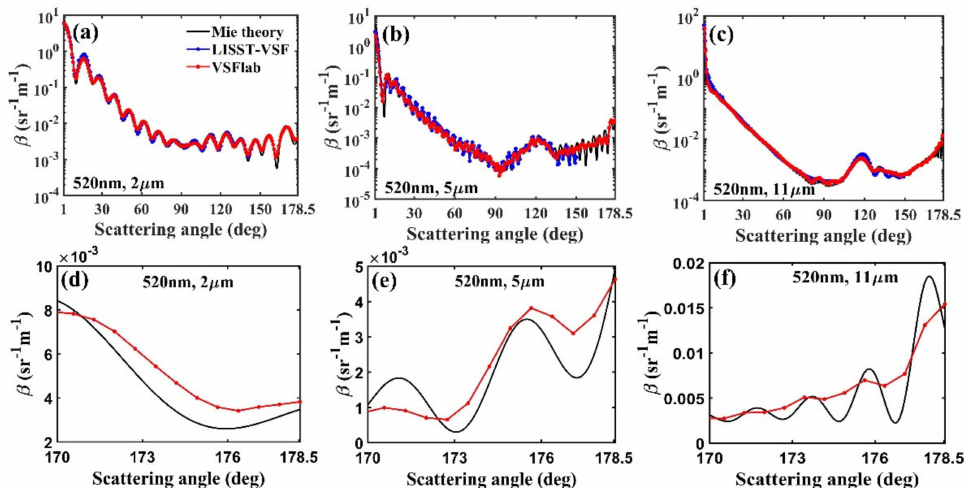
Figure 7. ( a – c ) VSFs for 2, 5, and 11 µ m beads at 520 nm. The blue line denotes the results measured by LISST-VSF, and the red line denotes the results measured by VSFlab. The black line corresponds to the theoretical curves calculated from Mie theory. ( d – f ) Same as ( a – c ) but for angles between 170 ◦ and 178.5 ◦